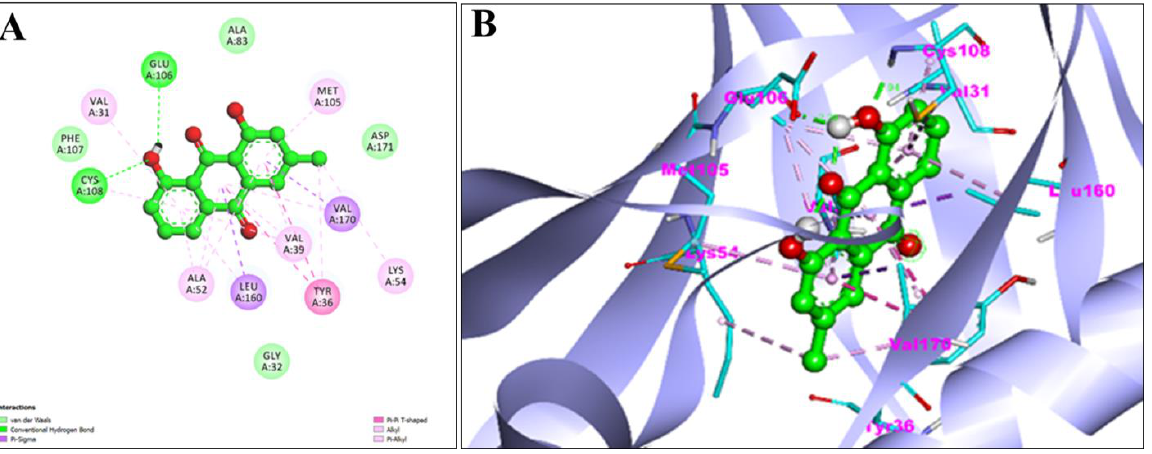
Figure 9. 2D ( A ) and 3D ( B ) representation of interaction of chrysophanol (green color) and human Traf2- and NCK-interacting protein Kinase (purple color with ribbon pattern) (PDB:2X7F).